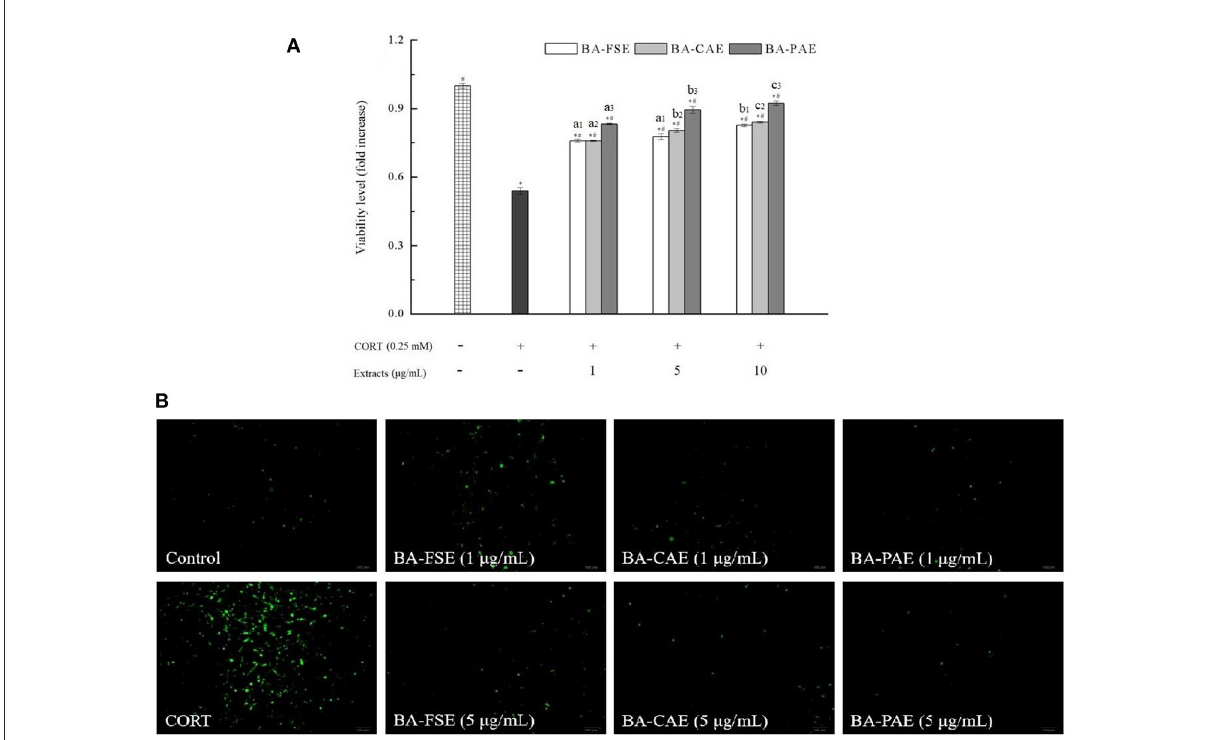
FIGURE5 Effects of different blackberry extracts at different concentrations on cytoprotection in PC12 cells. (A,B) Showed the cell viability and ROS release level, respectively. * and # indicated the significant differences at P < 0.05 between control group and others, and oxidative model group and other, respectively. Mean values of the same extract with different lowercase letters were significantly different at P < 0.05.